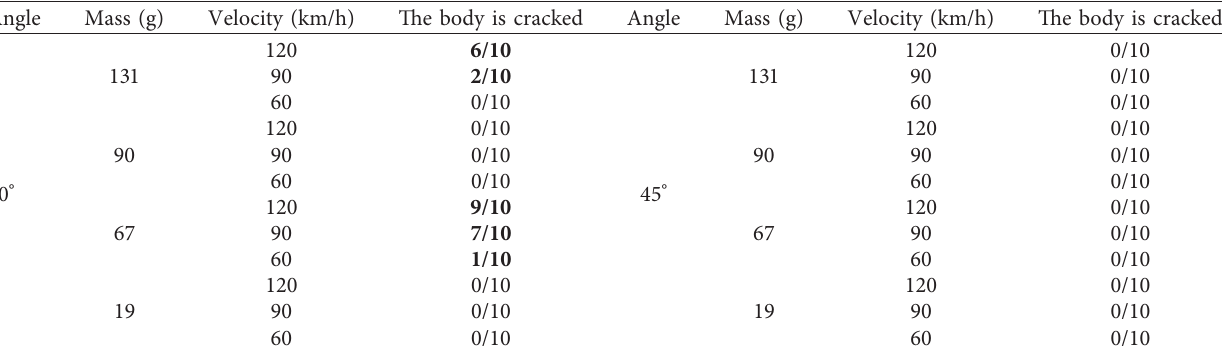
Table 3: Test results II.